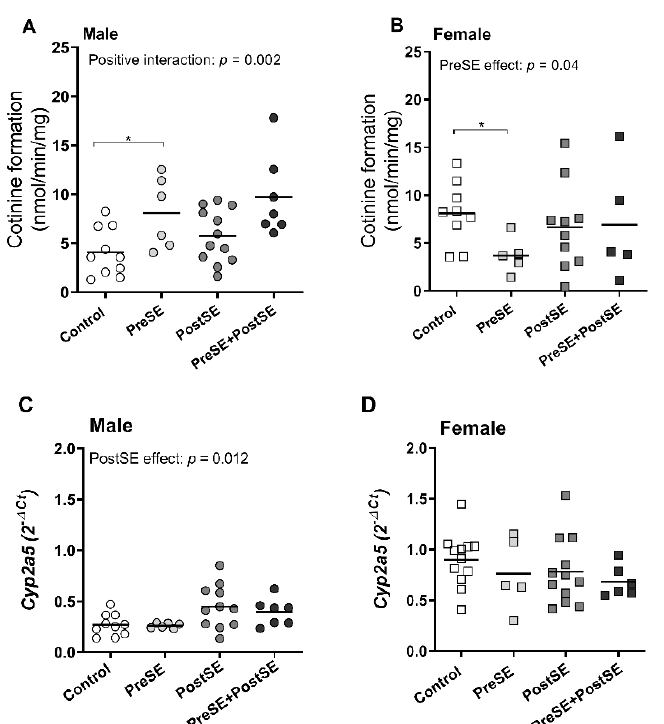
Figure 1. Cotinine formation rate of in vitro nicotine metabolism in the liver from (prenatal and postnatal) smoke exposed and control groups. Cotinine formation of hepatic nicotine metabolism and Cyp2a5 mRNA expression were measured in liver from control, postnatal smoke exposed (PostSE), prenatally smoke exposed (PreSE), and the combined with prenatally smoke exposed and postnatal smoke exposed (PreSE/PostSE) mice. The cotinine formation rates ( A , male and B , female) and mRNA expression ( C , male and D , female) were measured by high performance liquid chromatography (HPLC) and qRT-PCR analysis as described in the Section 4. Circle ( ○ ) symbol(s) = male, square (□) symbol(s) = female. The linear regression analysis was performed among all groups. A positive interaction indicates a significant interaction between the effect of smoking during pregnancy and postnatal smoke exposure. Data are shown as individual values. If not stated otherwise, the comparison of shown groups was not significant. * p ≤ 0.05, (Mann–Whitney U -test). Open symbol(s) = control group, closed symbol(s) = (prenatally) smoke exposed group.